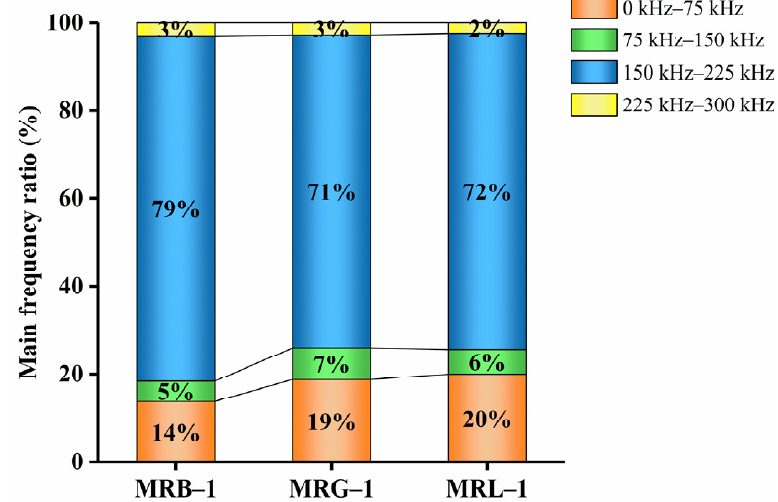
Figure 13. Percentage of medium frequency bands in the crack growth phase.